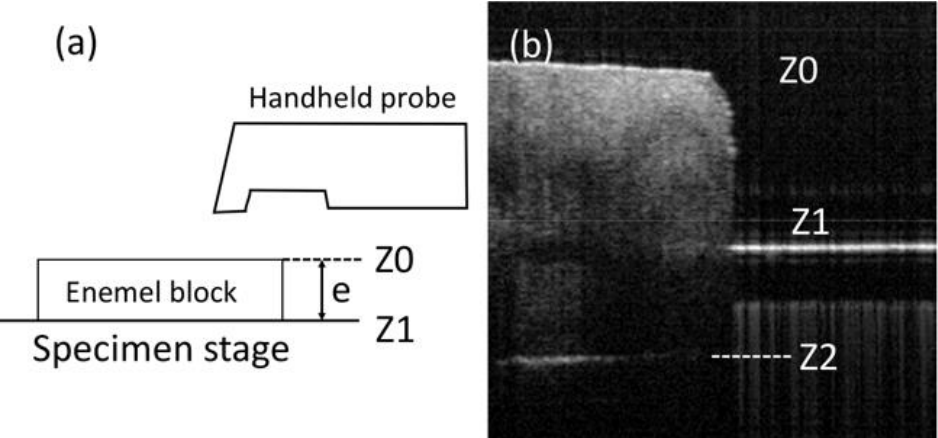
Figure A4. ( a ) Schematic diagram of an enamel block imaged with OCT; ( b ) OCT image of the specimen stage and enamel. Z 0 is the specimen surface; Z 1 is the specimen stage location, and Z 2 is the specimen stage location imaged through the specimen.